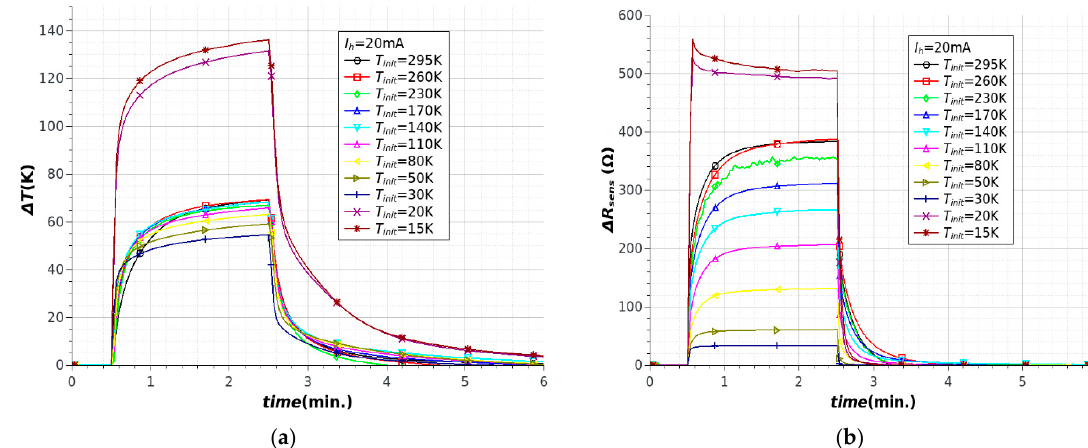
Figure 10. Heating of microstructures at cryogenic temperatures: ( a ) temperature changes; ( b ) sensor resistance changes. Sensors 2018 , 18 , x FOR PEER REVIEW